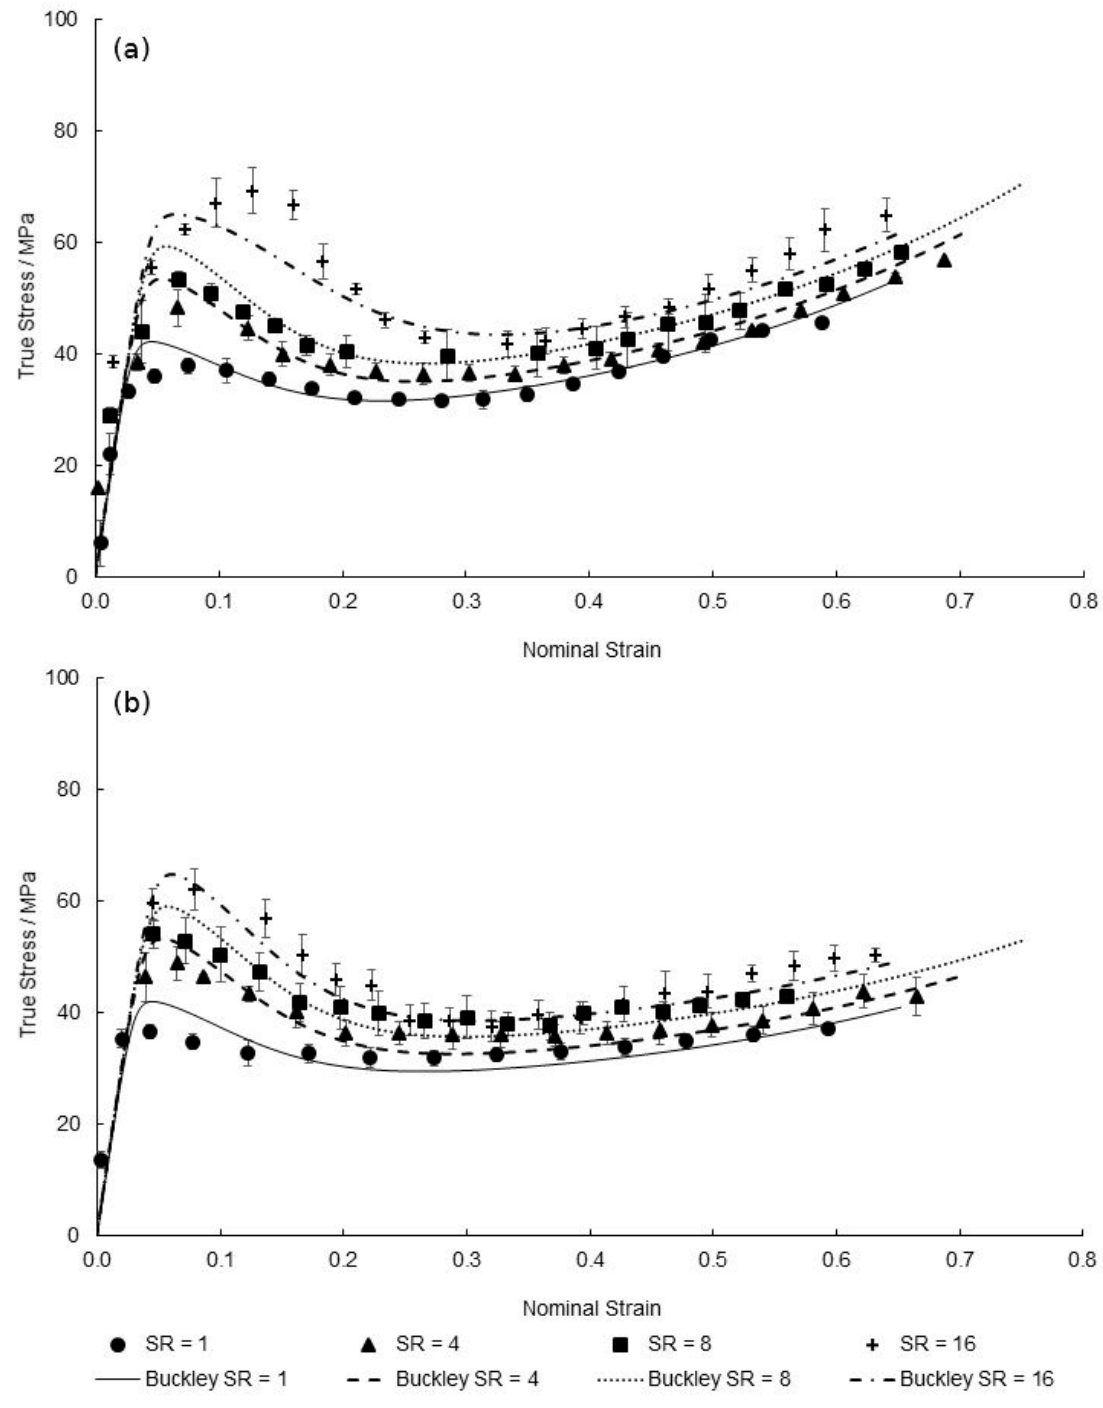
Figure 21. Predicted EB deformation behaviour by modified Buckley model for strain rates between 1 and 16 s − 1 , at a temperature of 130 °C in the ( a ) machine direction and ( b ) transverse direction.